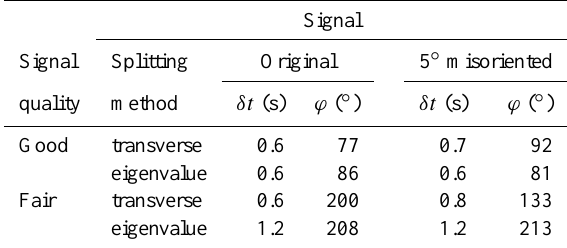
Table 2. Synthetic tests of seismometer